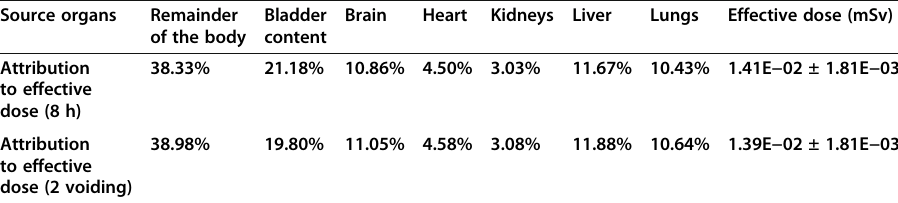
Table 4 Contribution to effective dose from different source organs Source organs Remainder Bladder Brain Heart Kidneys Liver Lungs Effective dose (mSv) of the body content Attribution to effective